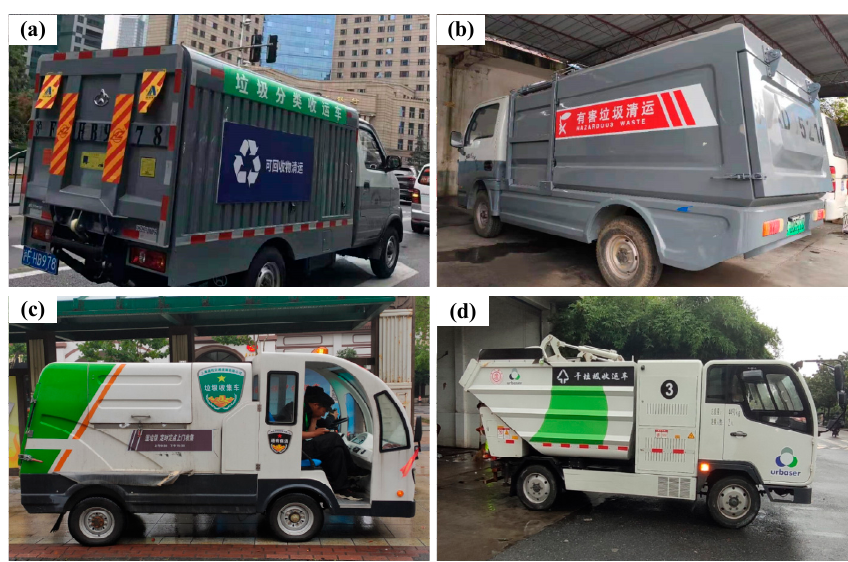
Figure 2. Transportation vehicles of different categories of waste: ( a ) recyclable waste, ( b ) hazardous waste, ( c ) wet waste, ( d ) dry waste.